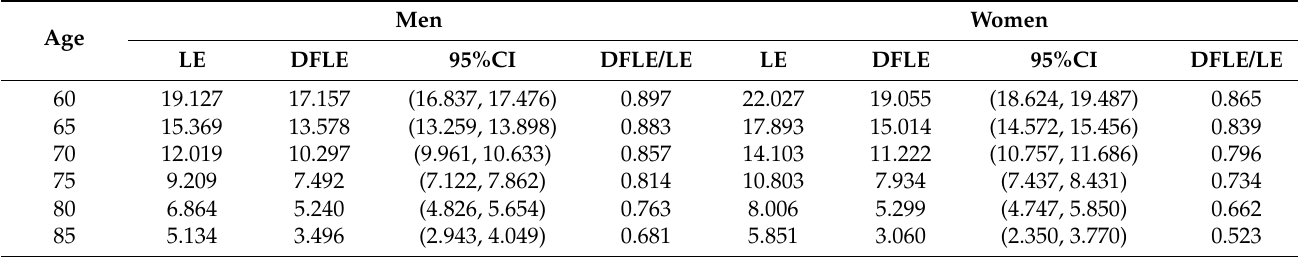
Table 1. LE, DFLE, and the proportion of DFLE in Jiangxi Province, China, by sex and selected ages for the year 2018. Men Age